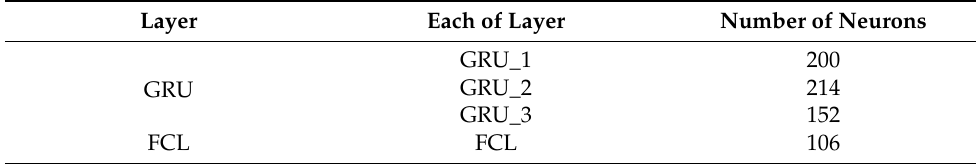
Table 1. Optimized of parameters of GA-GRU model. Layer Each of Layer